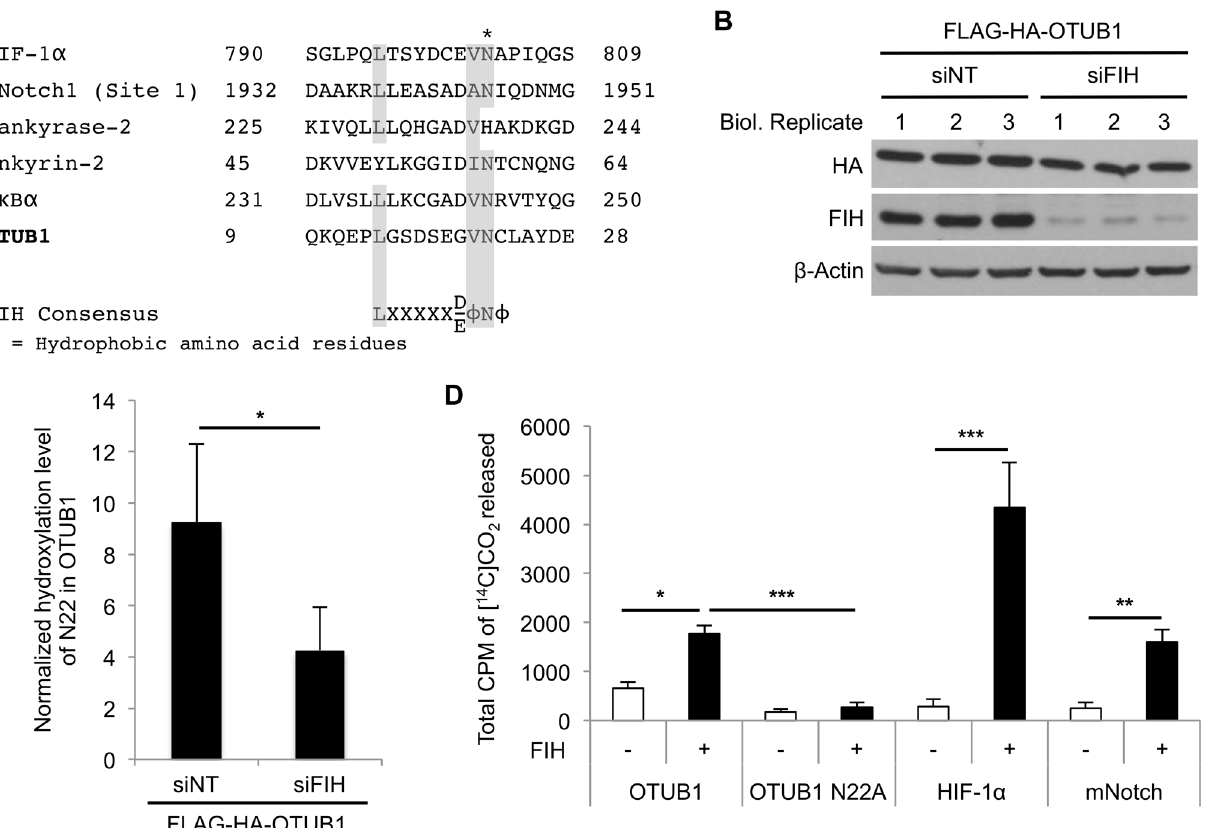
Fig 3. FIH hydroxylates OTUB1 on asparagine 22. (A) Sequence alignment of OTUB1 with previously identified FIH target proteins reveals that N22 lies within an FIH consensus motif in OTUB1. Amino acid residues that are part of the FIH consensus sequence in human OTUB1 are highlighted in gray. The FIH-targeted N22 residue of human OTUB1 is highlighted with “ * ” . (B) Western blot analysis demonstrating effective knockdown of FIH in HEK293 cells. (C) Hydroxylation levels of OTUB1 N22 of the samples shown in (B) after FLAG-specific immunoprecipitation. The detected hydroxylation peptide intensity of each sample was normalized to the amount of non-hydroxylated OTUB1 N22 peptide intensity detected. (D) In vitro CO 2 capture assay for MBP-hFIH- 1-catalyzed hydroxylation-coupled stoichiometric release of 14 CO 2 from [1- 14 C]-2-oxoglutarate with synthesized peptides as FIH substrates containing demonstrated hydroxylation sites of HIF-1 α , NOTCH and the putative hydroxylation site (N22) of OTUB1. An OTUB1 peptide containing a N22A point mutation was used as control for an N22-specific reaction. The experiment described in (C) was performed with three biological replicates and two technical replicates per sample and data are presented as mean + SD; * p < 0.05 by Student ’ s t test. Data presented in (D) as mean + SD of n = 3 experiments; * p < 0.05, ** p < 0.01, *** p < 0.001 by one-way ANOVA followed by Tukey post test. The underlying data of panels C and D can be found in S1 Data.